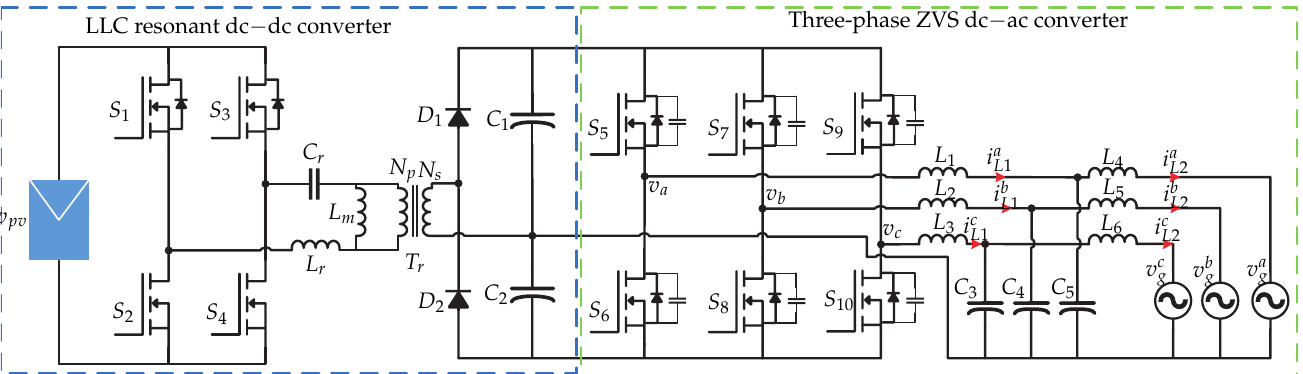
Figure 6. Microinverter’s topology proposed in [15].